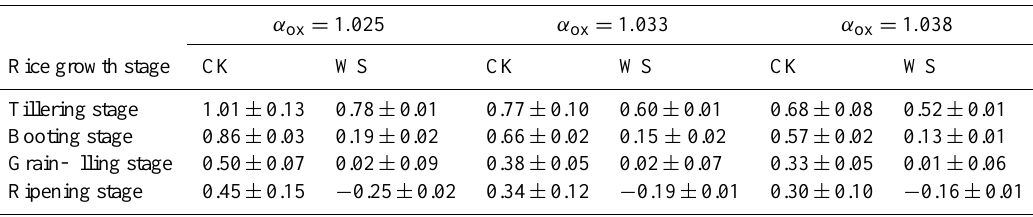
Table 7. Fraction of CH 4 oxidized ( F ox ) a in paddy fields at the four rice growth stages; mean ± SD, n = 3. WS: straw incorporation, CK: without straw incorporation. α ox = 1 . 025 α ox = 1 . 033 α ox = 1 .